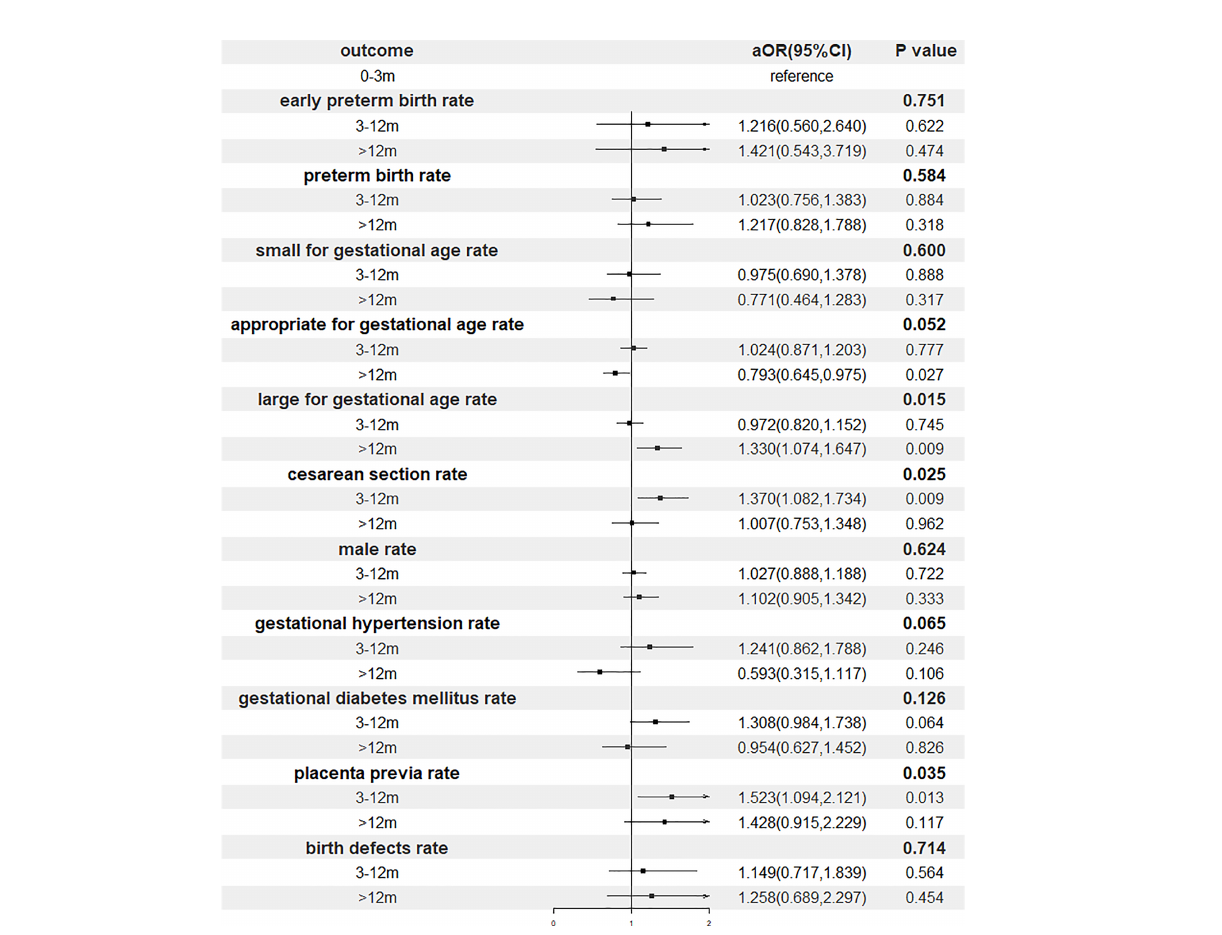
FIGURE 3 | Forest plot of adjusted odds ratio of perinatal outcomes. OR, odds ratio; CI, con fi dence interval.